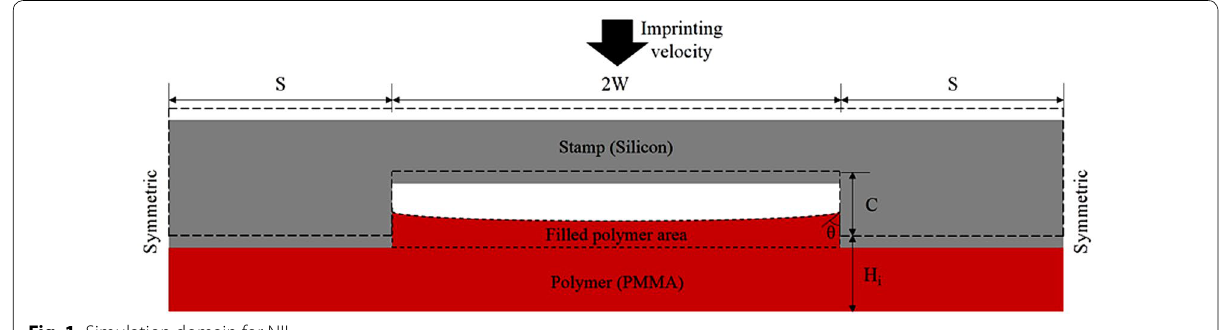
Fig. 1 Simulation domain for NIL